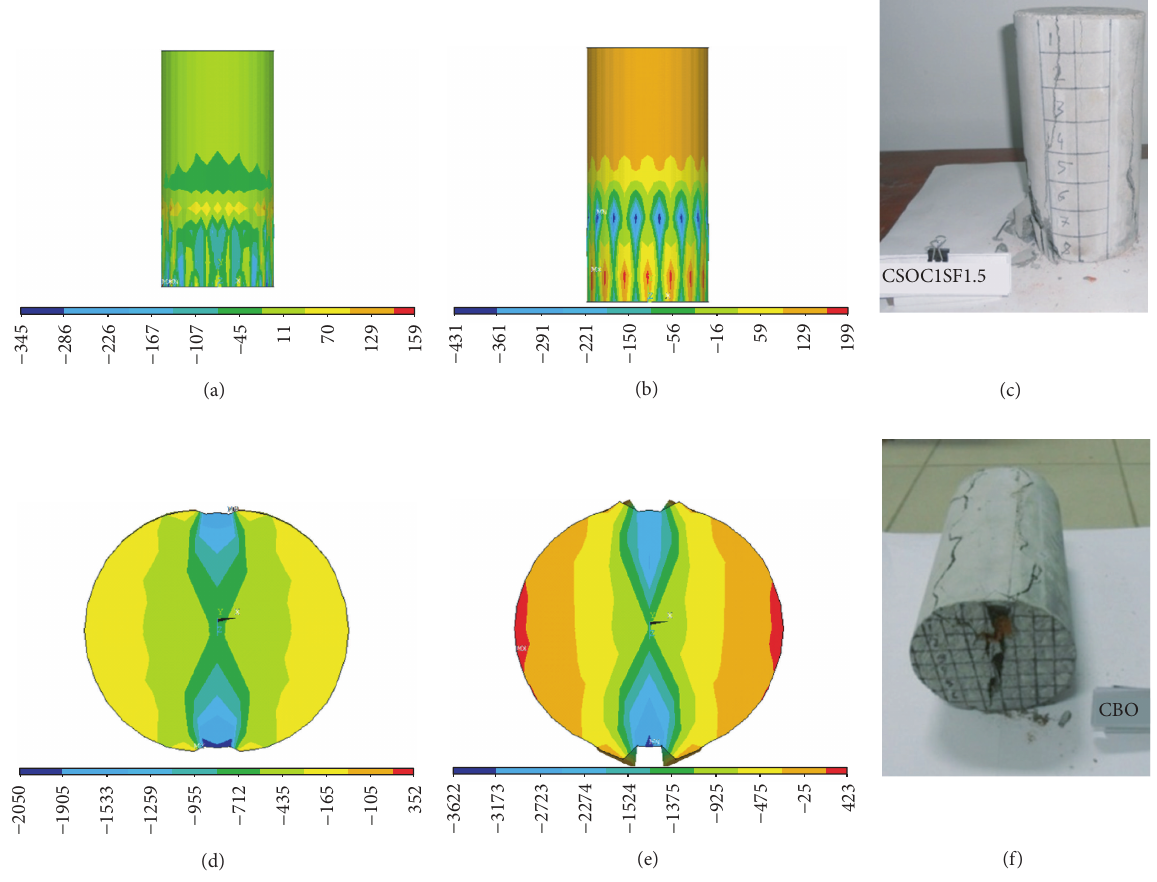
Figure 9: Typical stress contour of FE models, ((a), (b)) 𝑌 direction stress contour of control and SFRC specimen for compression test, respectively, (c) failure occurring at same location during test, ((d) and (e)) 𝑍 direction stress contour of control and SFRC specimen for compression test, respectively, and (f) failure pattern during